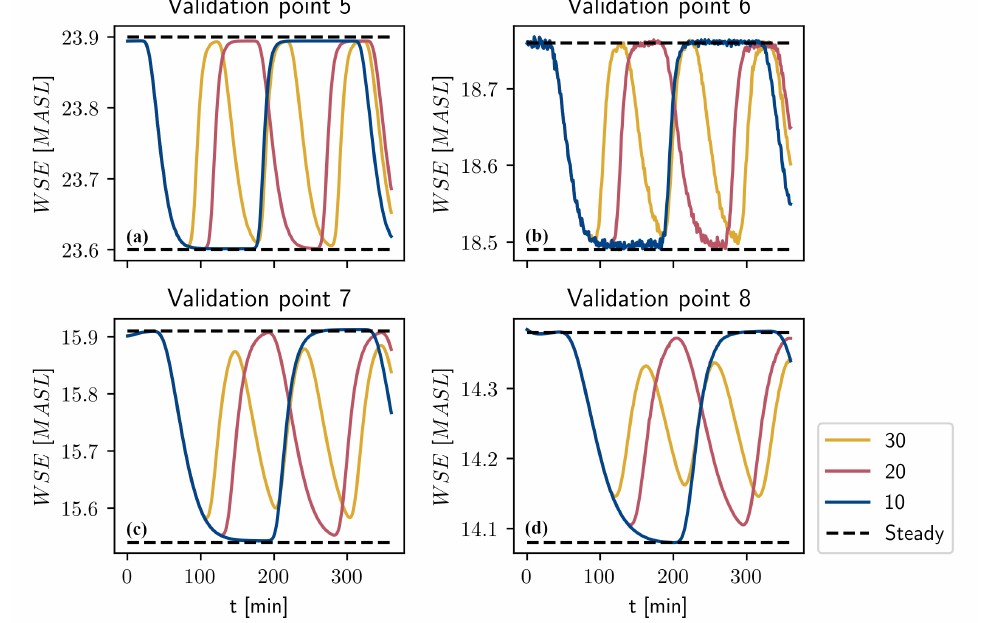
Figure 9. WSE for the points 5, 6, 7, and 8 given the flow scenarios with 10, 20, and 30 flow changes per day. ( a ) Validation point 1. ( b ) Validation point 2. ( c ) Validation point 3. ( d ) Validation point